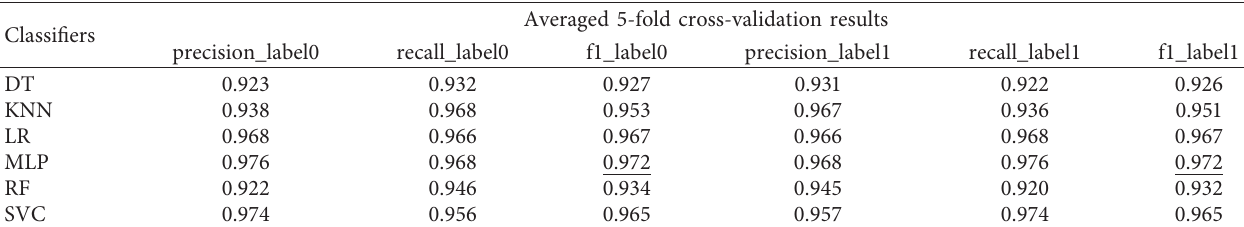
Table 4: Averaged 5-fold cross-validation results of each classifier with feature augmentation.